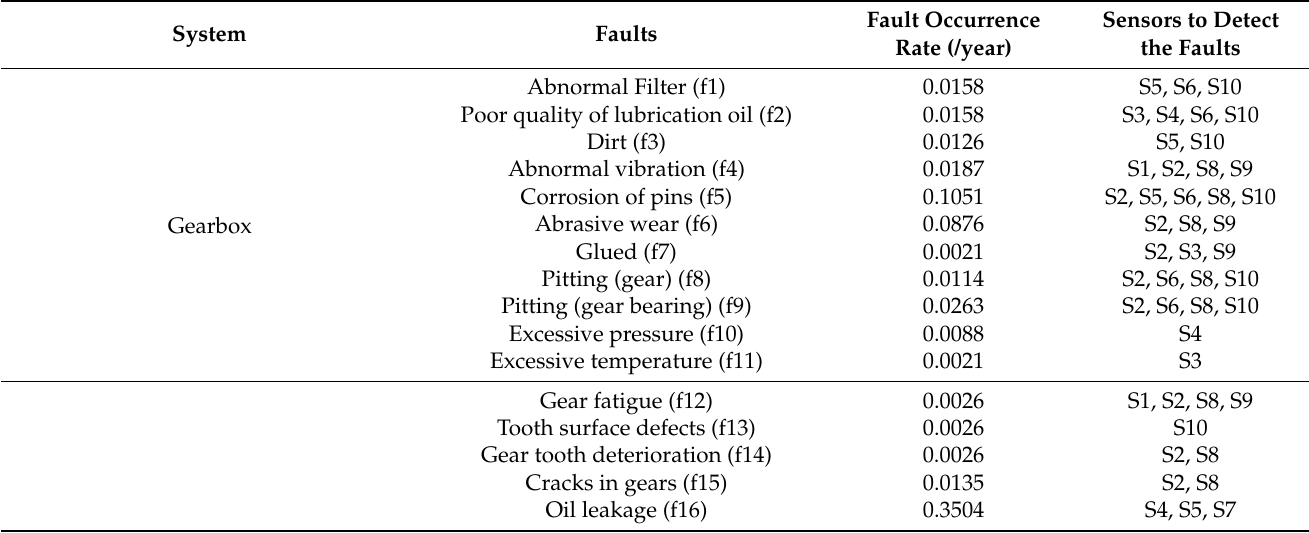
Table 3. Faults under consideration.